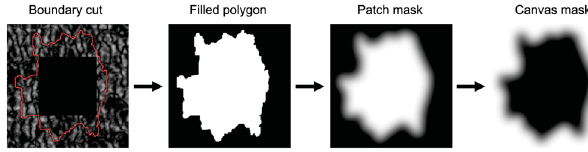
Fig. 5 Optical error image Δ I (1); naive transfer of rectangular patch exposing visual discontinuities (2); minimum boundary cut through optical error field (3); transfer of boundary region (4).